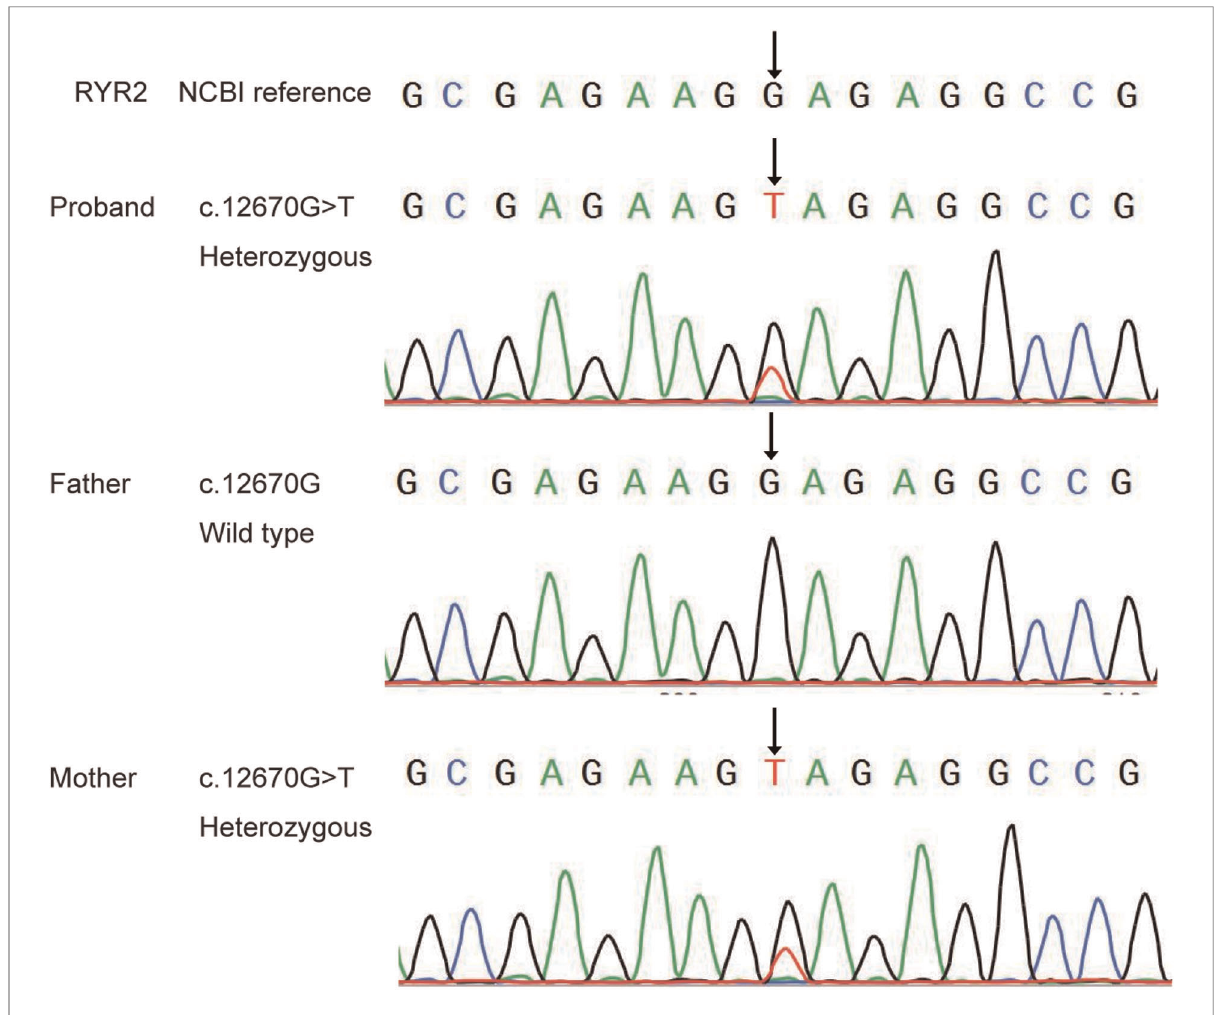
FIGURE 2 Sanger sequence analysis of the novel mutation of RYR2 gene in the proband and his